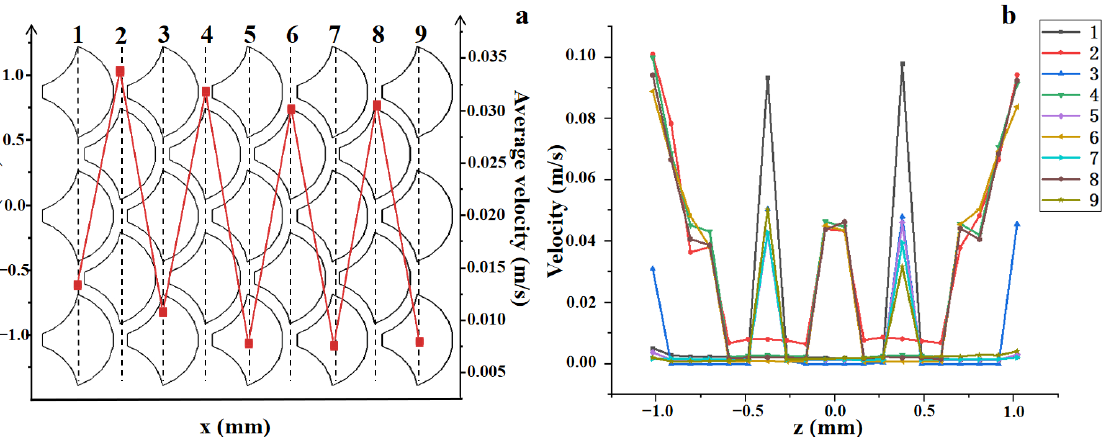
Figure 22. Velocity distribution of each scale column. ( a ) Average velocity on each of scale column; ( b ) The velocity distribution of each column.